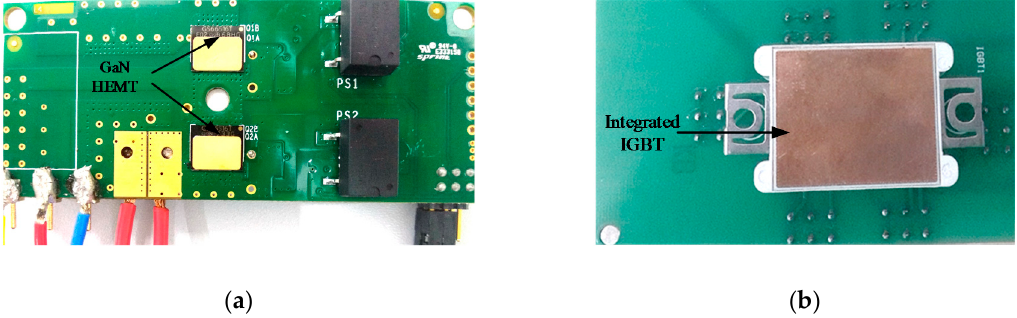
Figure 1. Power devices studied in this paper. ( a ) GaN HEMT. ( b ) IGBT.